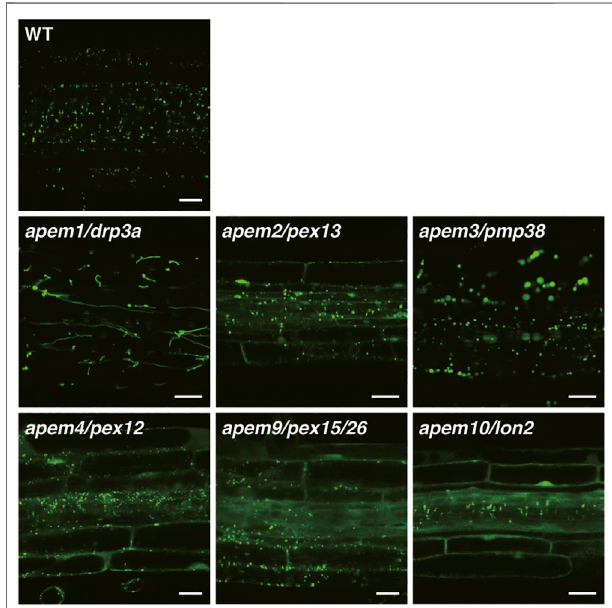
FIGURE 2 | GFP fl uorescence in root tissue of the WT plant and apem mutants expressing the peroxisome marker GFP-PTS1 (Mano et al., 2004; Mano et al., 2006; Goto et al., 2011; Goto-Yamada et al., 2014a). Bars, 20 µm.